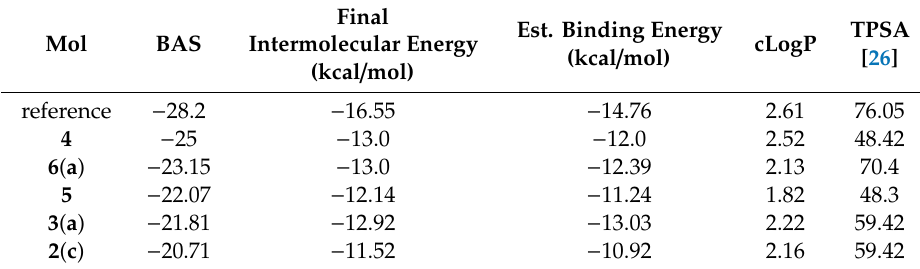
Table 2. Molecular Docking Parameters for the systems under consideration.